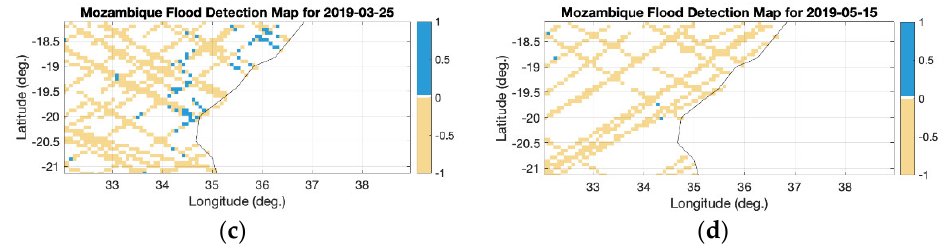
Figure 10. Flooding maps obtained from CYGNSS data using TES observable for ( a ) 15 January 2019, ( b ) 19 March 2019, ( c ) 25 March 2019 and ( d ) 15 May 2019.